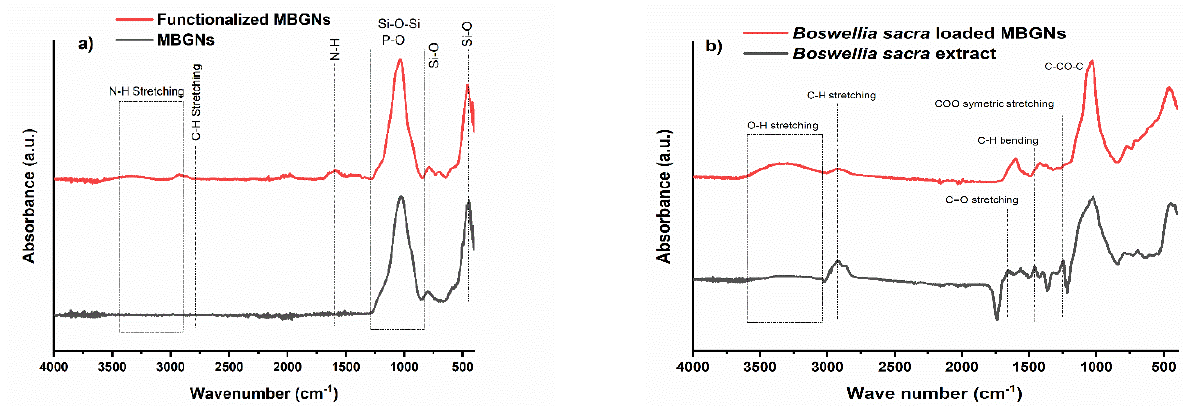
Figure 3. FTIR spectra of MBGNs and functionalized MBGNs ( a ), Boswellia sacra extract and Boswellia sacra -extract-loaded MBGNs ( b ). The indicated relevant peaks are discussed in the text.